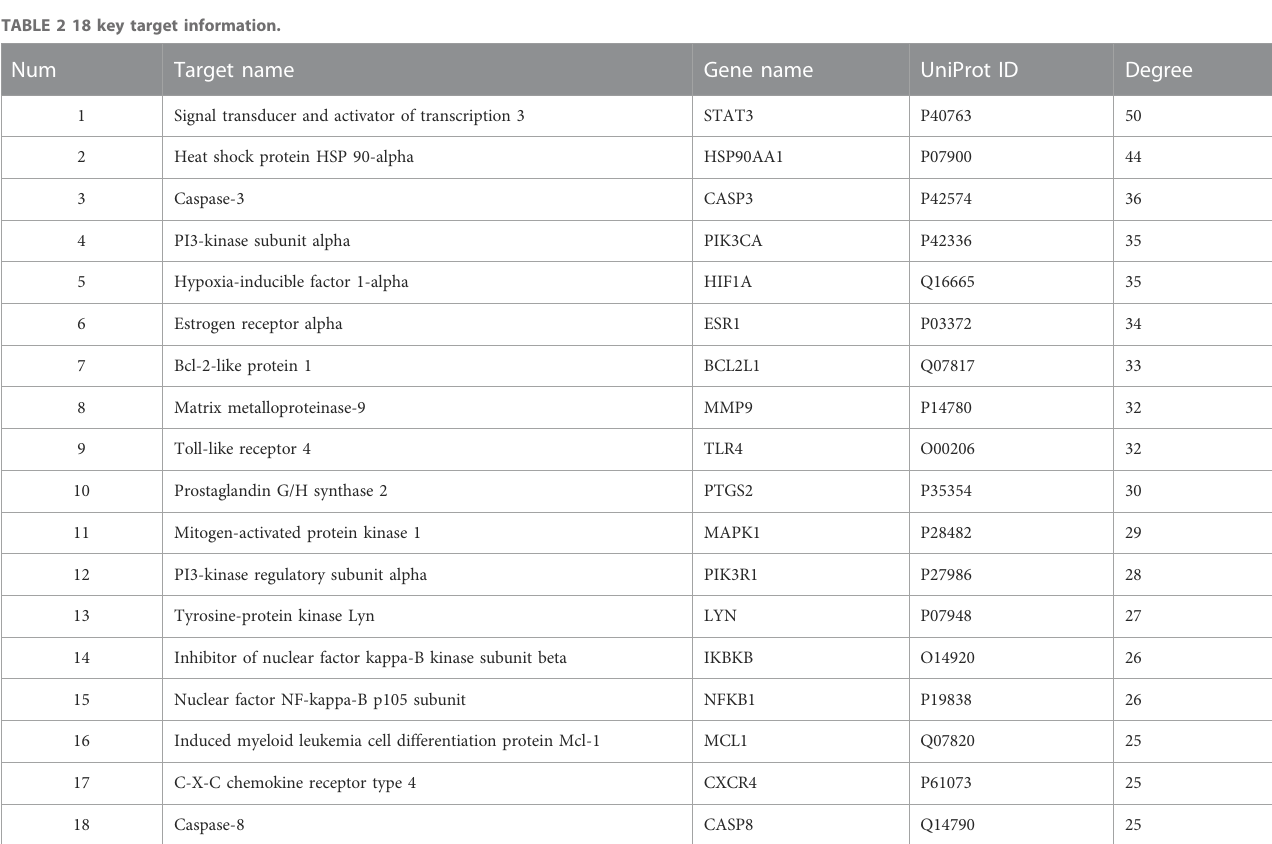
TABLE 2 18 key target